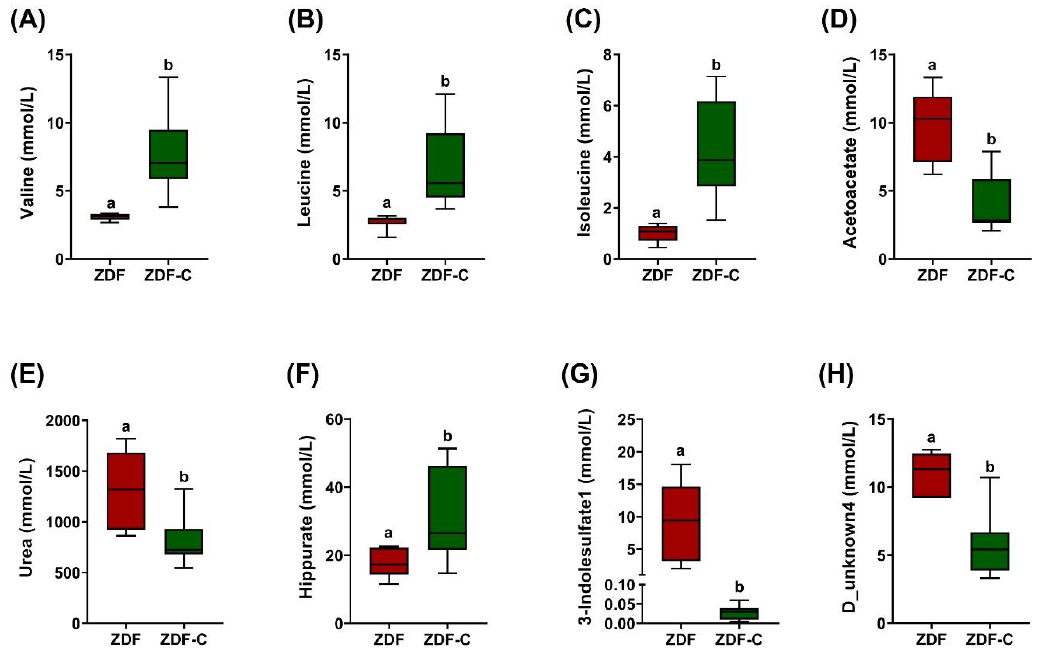
Figure 3. Altered urine metabolites between the diabetic (ZDF) and cocoa-supplemented diabetic (ZDF-C) rats at 20 weeks of life: ( A ) valine, ( B ) leucine, ( C ) isoleucine, ( D ) acetoacetate, ( E ) urea, ( F ) hippurate, ( G ) 3- indolelsulfate, and ( H ) D_unknow4 metabolite levels. Data represent the means ± SD of 6 – 8 animals. Different letters denote statistically significant differences, p < 0.05.